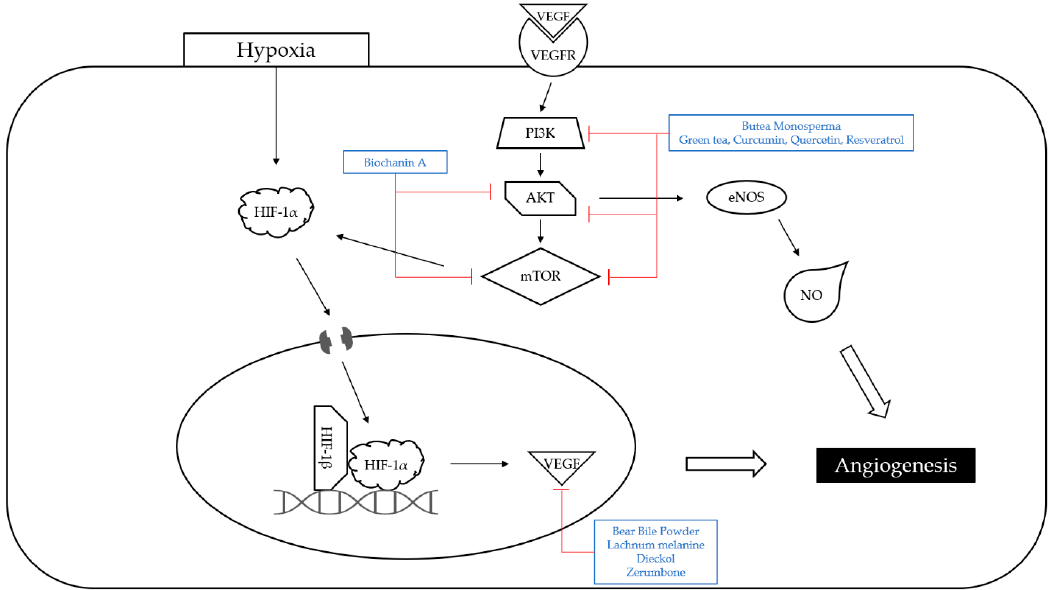
Figure 3. Schematic diagram of angiogenesis pathway. HIF-1 α , which is activated by hypoxia, induces VEGF synthesis and leads to angiogenesis. Moreover, PI3K/AKT/mTOR pathway regulates cell proliferation. PI3K was downregulated by Butea Monosperma and mixture of green tea, curcumin, quercetin, resveratrol extracts. Both AKT and mTOR were inhibited by Biochanin A, Butea Monosperma and mixture of green tea, curcumin, quercetin, resveratrol extracts. VEGF was downregulated by bear bile powder, Lachnum melanin, dieckol, and zerumbone. The mechanisms of natural products affecting angiogenesis were indicated. The upregulations of the molecules were marked with a green arrow and the downregulations with a red arrow.